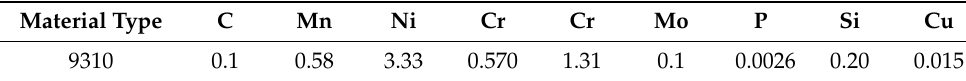
Table 3. Chemical composition (wt.%) of 9310 alloy steel.